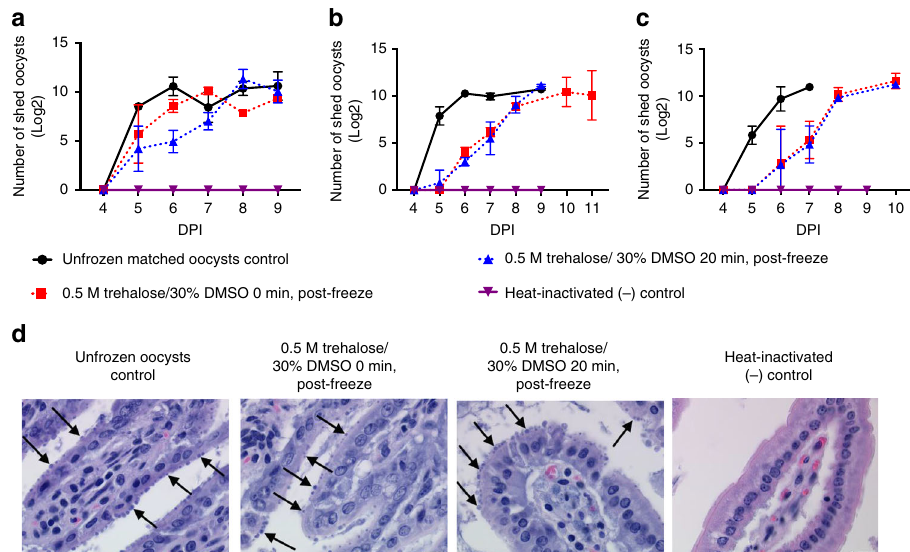
Fig. 3 Cryopreserved C. parvum oocysts are infectious to IFN- γ knockout mice. Dehydrated oocysts were vitri fi ed using either the 0 min or 20 min DMSO incubation protocol. IFN- γ knockout mice ( n = 2 – 3) were inoculated orally with 5000 PI - thawed or unfrozen control oocysts. Intensity of fecal shedding was quanti fi ed daily by microscopic enumeration of oocysts in 30 fi elds of acid-fast stained fecal smears under 1000× magni fi cation. Positive (unfrozen) and negative controls (heat-inactivated) were included as matched controls. To determine whether oocyst age has effect on the success of the cryopreservation protocol, a 1- b 6- and c 12-week-old oocysts were studied. Values indicate means of log transformed oocyst counts and error bars indicate standard deviation. Viability of oocysts was determined by PI exclusion prior to inoculation and was as follows: ( a ) 43.1% and 76.7% ( b ) 45.2% and 80.6% ( c ) 53.1% and 72.4%, for 20 min and 0 min incubations, respectively. d Micrographs of hematoxylin and eosin – stained jejunal sections from IFN- γ mice infected with fresh, cryopreserved or heat-inactivated 12-week-old oocysts are shown. Arrows indicate intracellular stages of the parasite located in the apical region of intestinal epithelial cells. Scale indicates 20 µ m. Data regarding infectivity of each individual mouse can be found in Supplementary Fig. 6